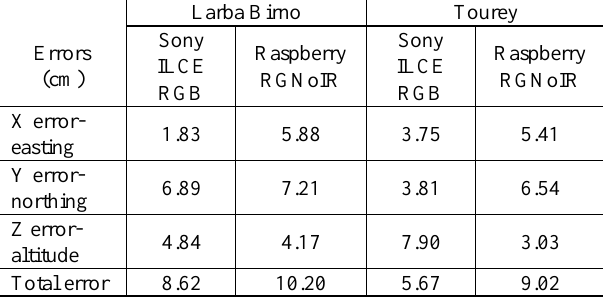
Table 7. RMSE value of the control points in